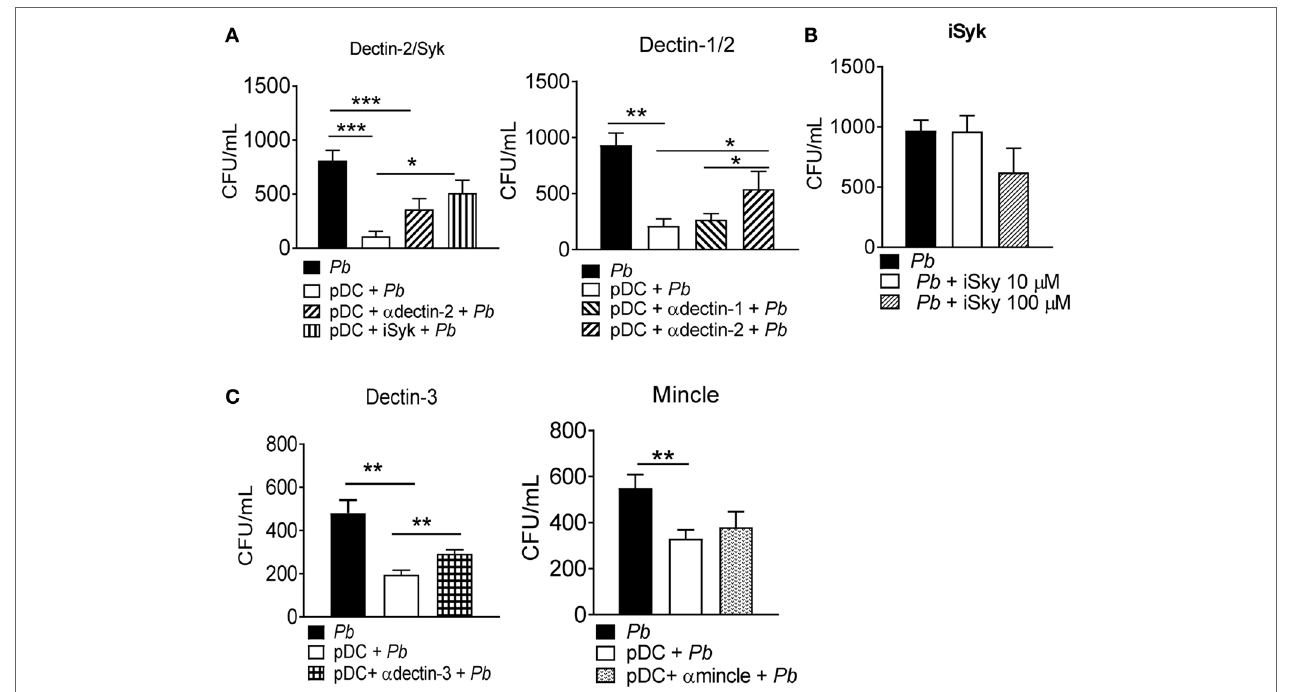
FigUre 5 | Dectin2, dectin-3, and Syk signaling activate the fungicidal activity of plasmacytoid dendritic cells (pDCs). Peripheral blood mononuclear cells were separated into pDC-positive populations (pDCs + ) using magnetic beads conjugated to anti-CD304 antibody. The cells (1 × 10 5 /well) were challenged overnight with P. brasiliensis yeast cells (2 × 10 3 ). (a) Some cultures were treated with anti-dectin-1, dectin-2, or with a Syk pathway inhibitor, piceatannol (10 µM). (B) The Syk inhibitor (10 or 100 µM) was also cultured with P. brasiliensis yeast cells only. (c) Futher, anti-mincle and anti-dectin-3 antibodies (100 µg/mL) were also used, before challenging with P. brasiliensis yeast cells. After 18 h of culture, the plates were centrifuged, and the supernatant was collected for cytokine measurements by ELISA. The pellet was lysed and suspended in 200 µL of phosphate-buffered saline. Next, 100 µL was transferred to BHI medium, and the colonies (CFU) were counted for 15 days. Data represent the means ± SE of the CFU from three donors, tested in triplicate. * p < 0.05, ** p < 0.01, *** p < 0.001 by comparing the data indicated by the